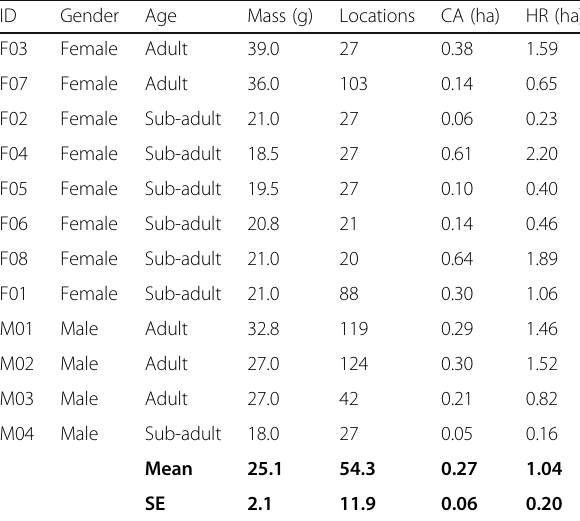
Table 1 Descriptive information of the tracked Dromiciops gliroides individuals (gender, age and body mass). The number of telemetry locations estimated for each individual is showed together with core areas (KDE 50%, in ha) and home